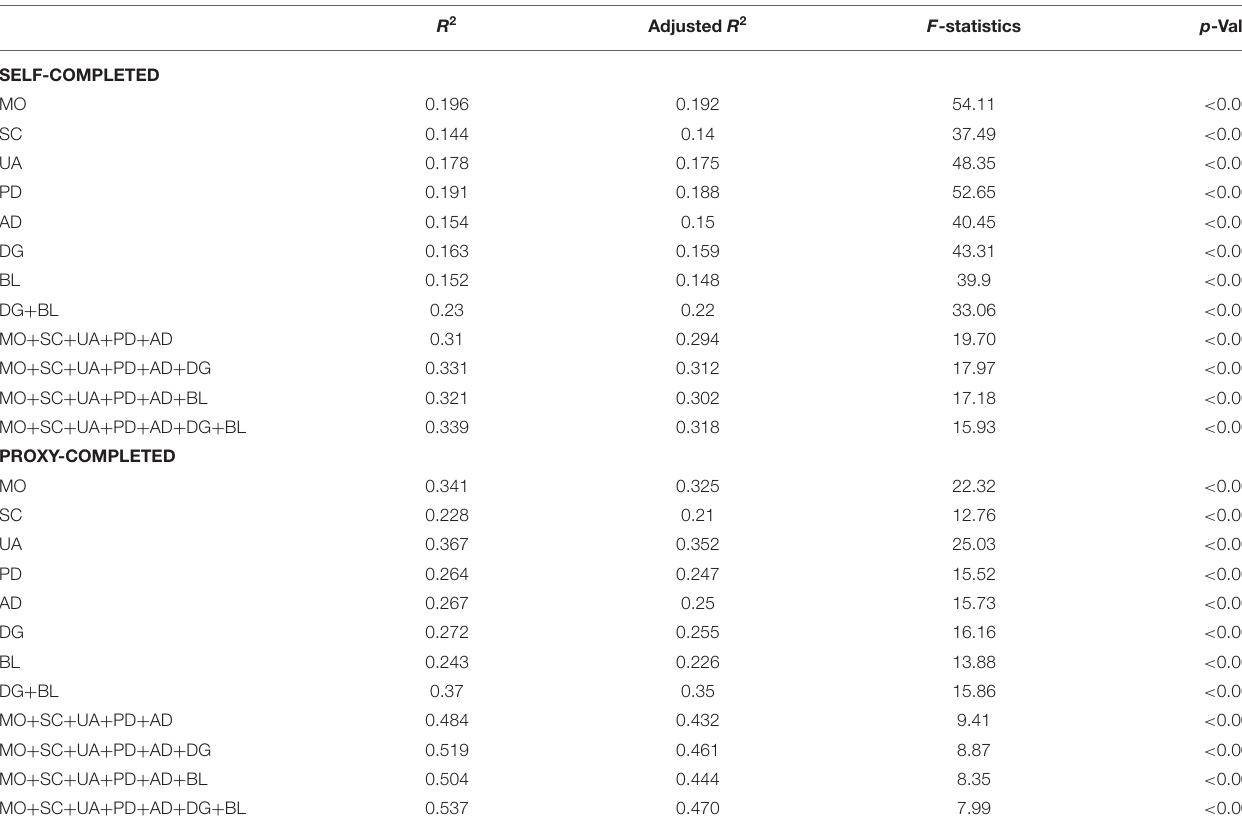
TABLE 4 | Regression analysis evaluating the impact of adding bolt-on items in predicting EQ-VAS score.